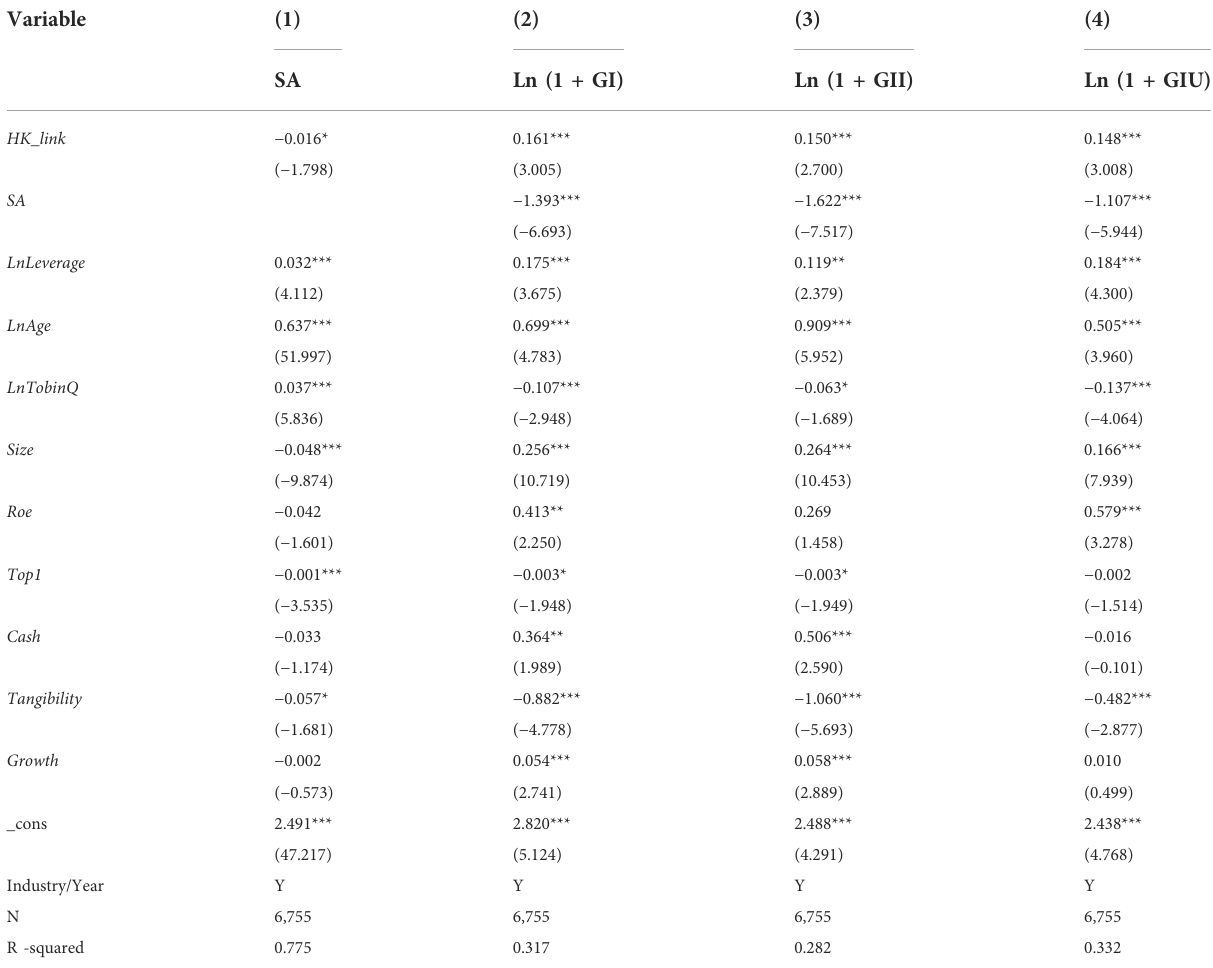
TABLE 5 Stock market liberalization, fi nancing constraints and green innovation.